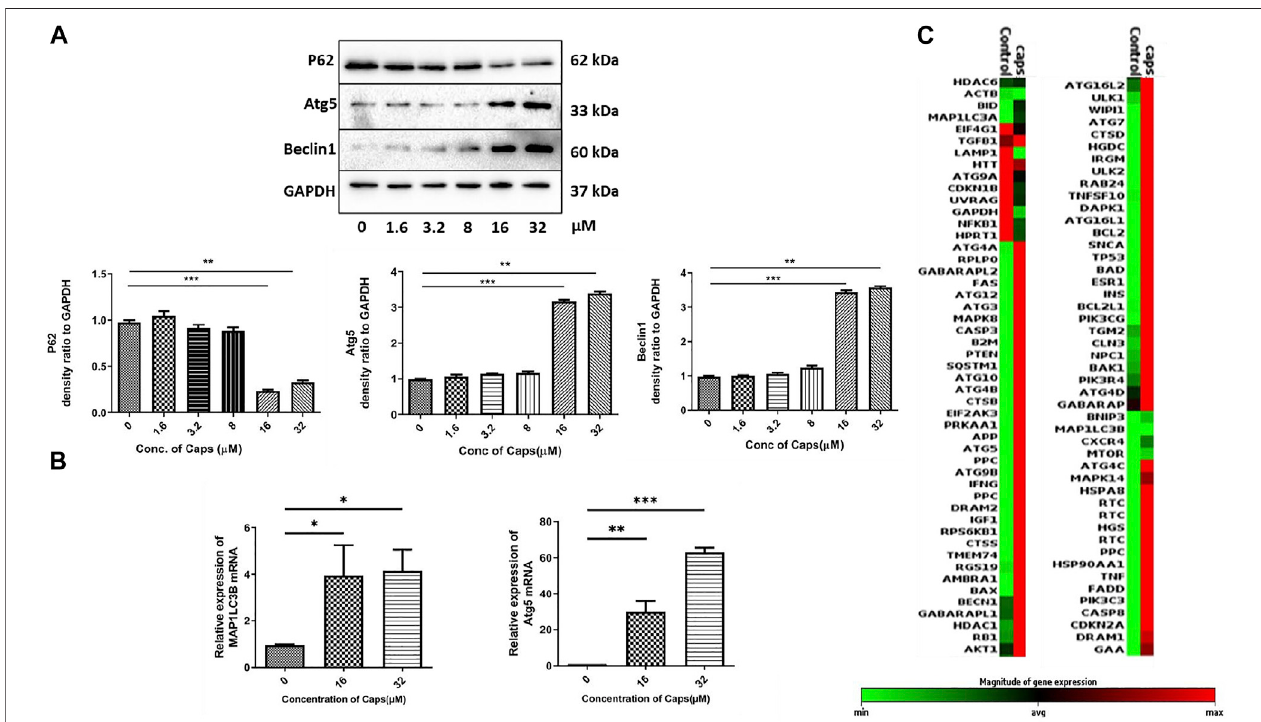
FIGURE 2 | Capsaicin (Caps) induces autophagy in intestinal cells. (A) HT29 cells were treated with Caps (1.6, 3.2, 8, 16, 32 µM) or DMSO for 2 h. Expression of major autophagy-associated marker proteins P62, Atg5, and Beclin1 was observed in western blot. GAPDH was used as a loading control. Densitometric analyses are graphically represented. (B) HT29 cells were treated with Caps (16, 32 µM) or DMSO for 2 h followed by qRT-PCR, Expression of the autophagy-associated marker genes(Map1LC3B,Atg5)wasquanti fi edusingGAPDHasahousekeepinggene.One-wayANOVAwasperformed. (C) PCRarraywasperformedwithcontroland only Caps-treated samples.Capstreatmentwasdone for4 h.Heat mapgeneratedrepresents differential geneexpression. Allexperimentswereperformedintriplicate. Graphs were generated using GraphPad Prism 5 were represented as mean ± SEM (n = 3); signi fi cance was calculated; * p < 0.05, ** p < 0.01, *** p < 0.001.